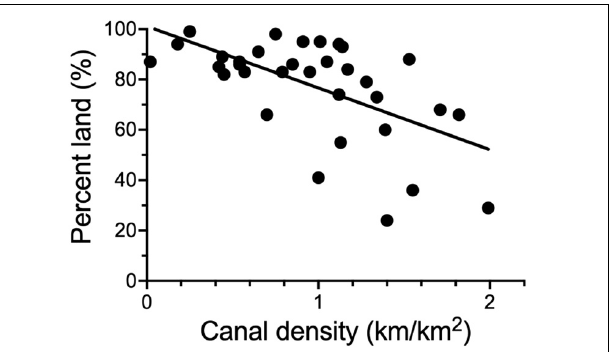
FIGURE 3 | The relationships between the percent land and canal density (canal length/land area) in 2 km diameter circles in Group 1 as of circa 2020. A simple linear regression of the data is